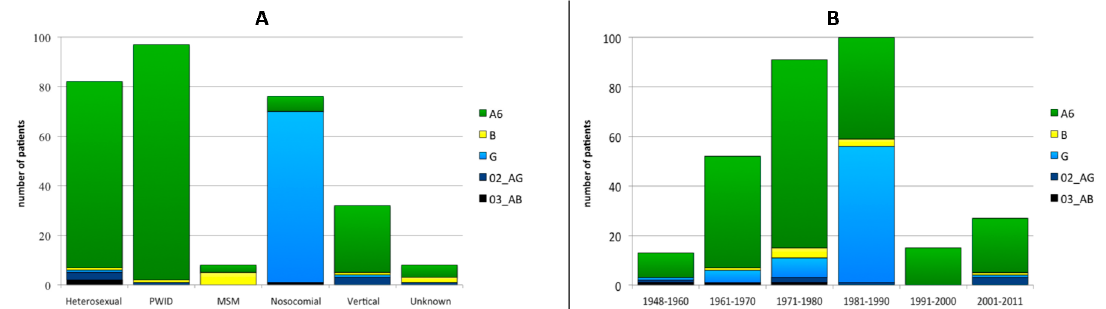
Figure 3. HIV-1 subtype distribution according to transmission route ( A ) and the year of birth ( B ) PWID: persons who inject drugs; MSM: men having sex with men.